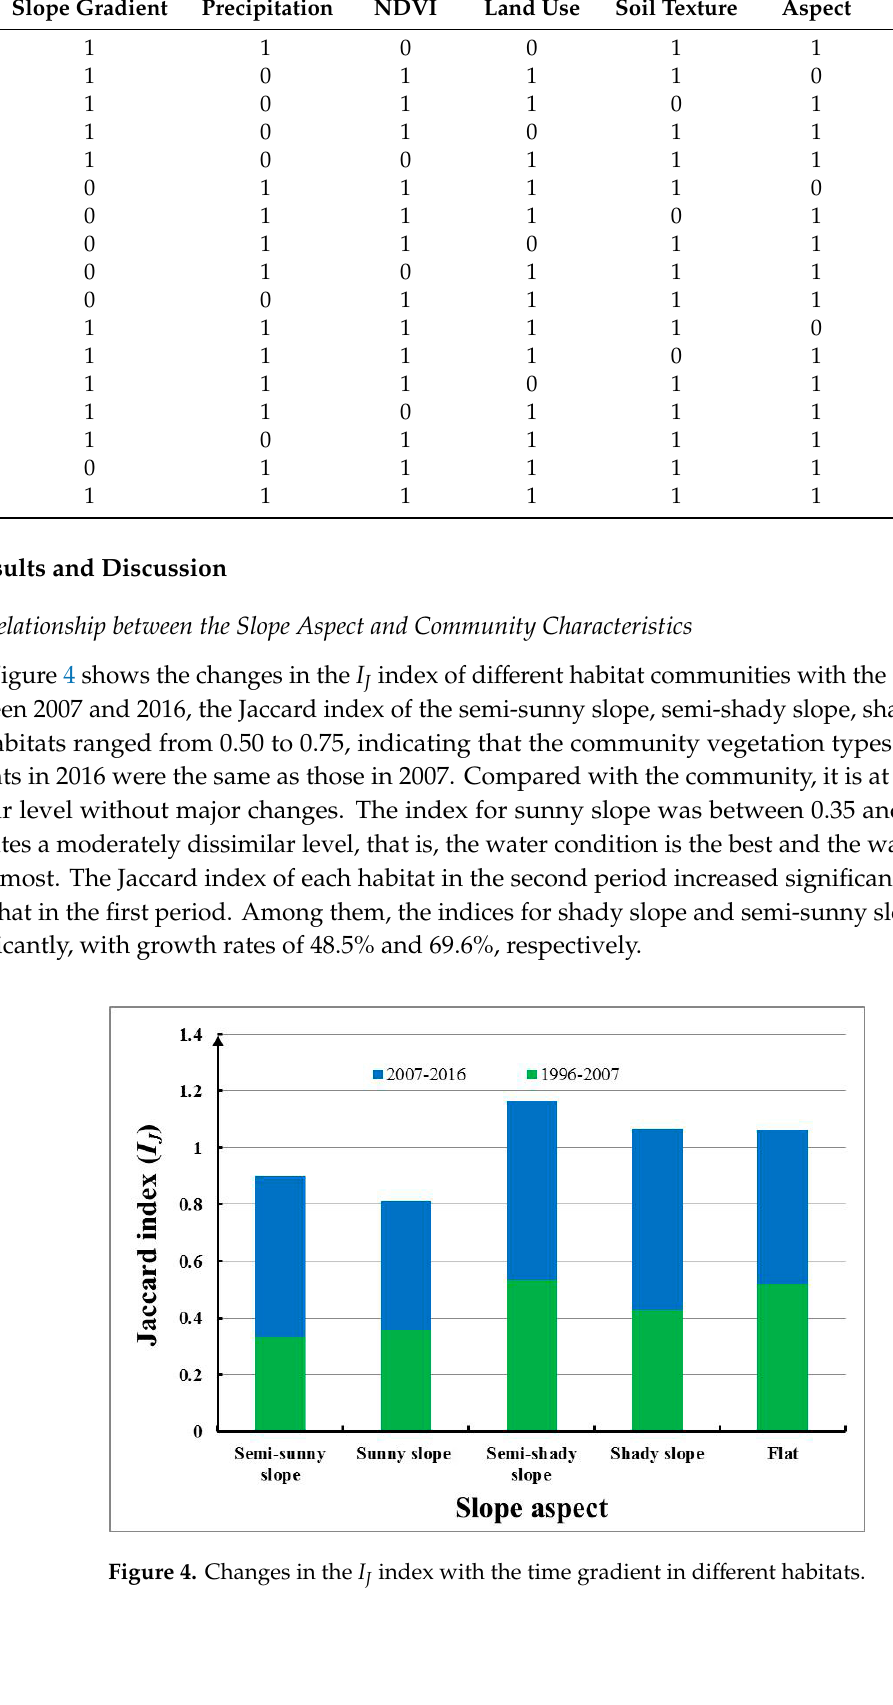
Figure 4. Changes in the I J index with the time gradient in different habitats.